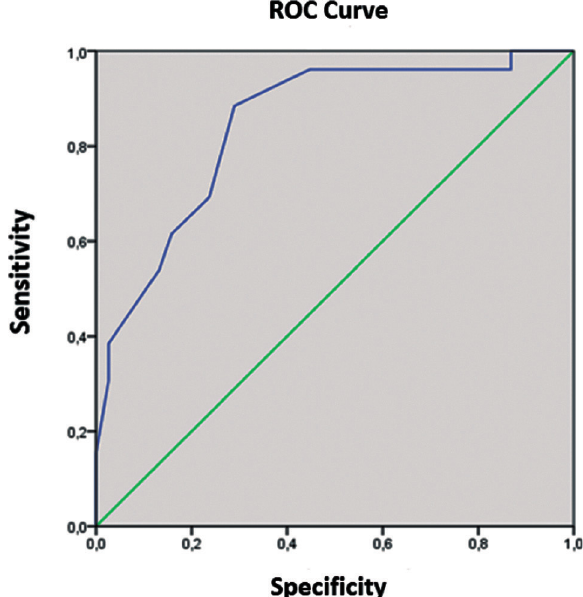
Figure 2. ROC curve determining cut-off score to distinguish Parkinson’s disease patients with mild cognitive impairment from patients with de- mentia using the